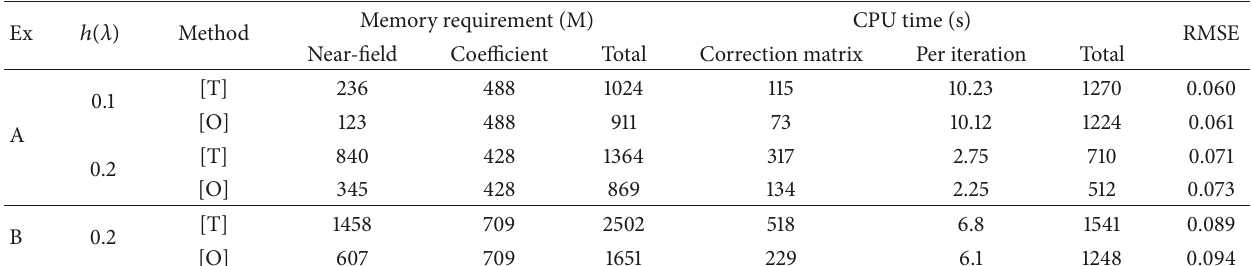
Table 2: Some related data for examples.